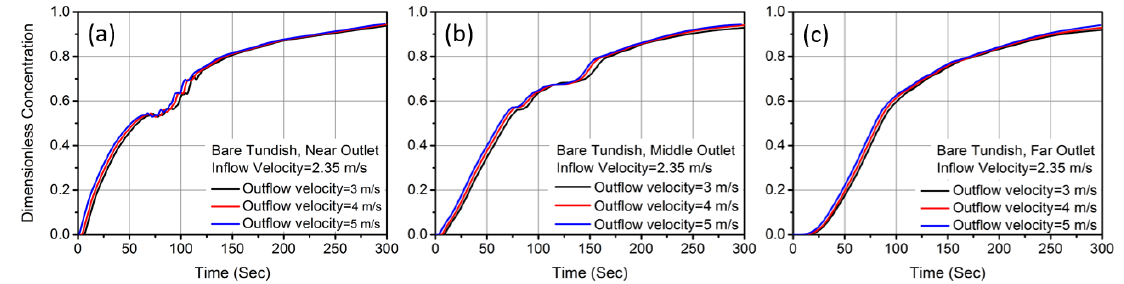
Figure 10. F-curves by varying outflow rate of bare tundish: ( a ) near outlet, ( b ) middle outlet, and ( c ) far outlet.